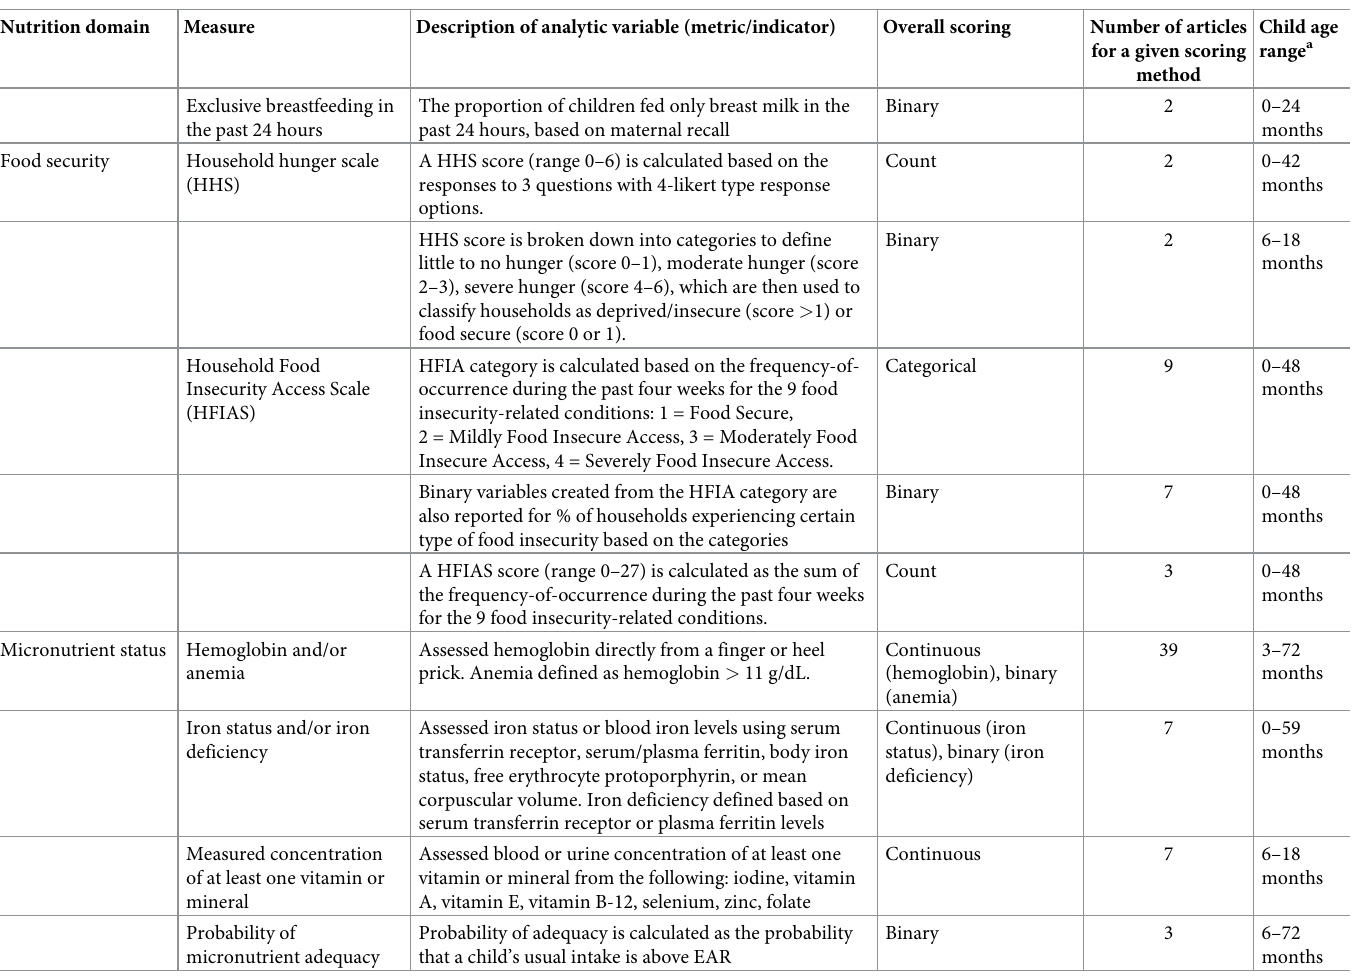
Four of the 11 indicators for breastfeeding practices and 6 of the 13 indicators for comple- mentary feeding practices were based on the 2008 WHO Infant and Young Child Feeding Indicators. The rest of the indicators for breastfeeding and complementary feeding practices